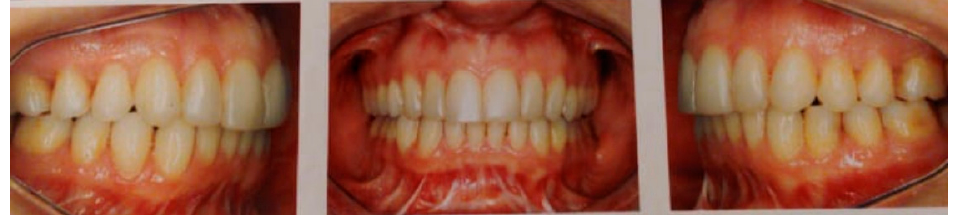
Figure 3. Postsurgical images show neglectable changes in the occlusion that, however, were accompanied by constant orofacial pain on the left